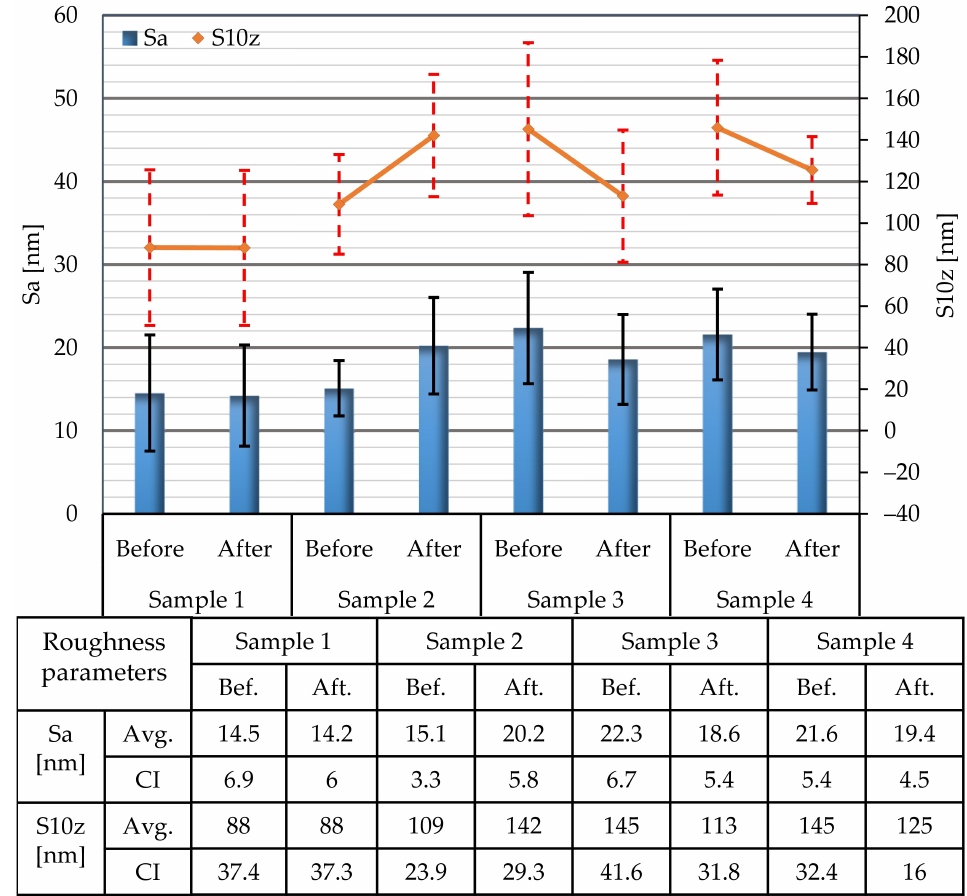
4Figure 4. Average values of Sa and S10z surface roughness parameters determined on areas of Figure 10 × 10 µ m and corresponding confidence intervals